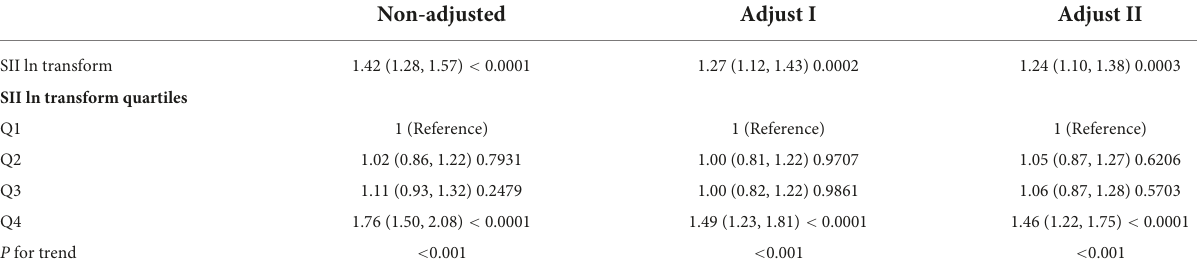
TABLE 2 Associations of the SII ln transform with all-cause mortality in individuals with ASCVD. Non-adjusted Adjust I